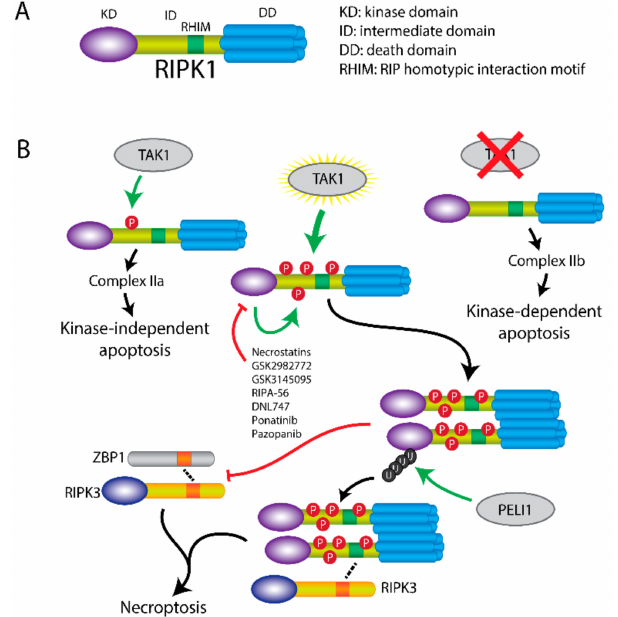
Figure 2. Cell death induction by RIPK1 regulation. ( A ) Scheme of RIPK1 structure. RIPK1 consists of an N-terminal kinase domain (KD), a RHIM containing intermediate domain (ID), and a C-terminal death domain (DD). ( B ) RIPK1-mediated cell death is regulated by TAK1. TAK1-induced phosphorylation